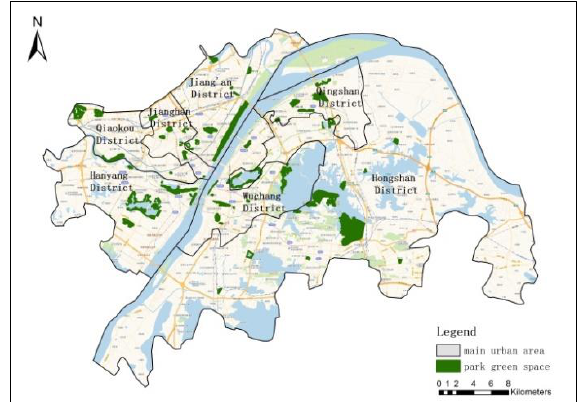
Figure 2. Distribution of park green space in the main urban area of